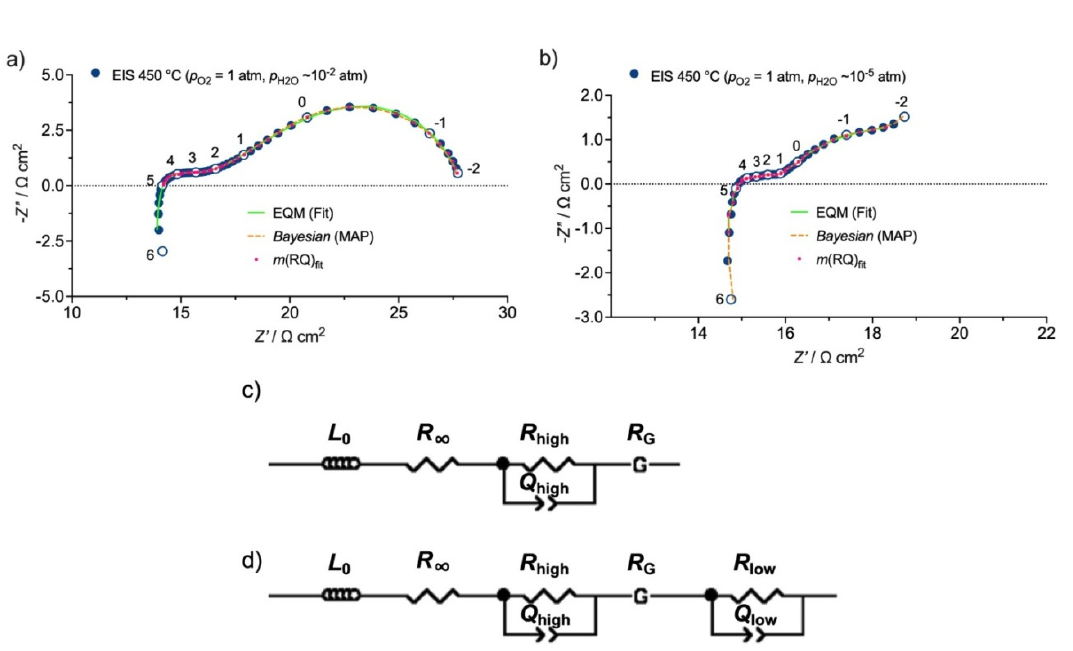
Figure 3. Impedance dispersions obtained under ( a ) wet ( p H2O ~ 10 − 2 atm) and ( b ) low humidity ( p H2O ~ 10 − 5 atm) conditions at 450 °C in O 2 atmosphere (numbers indicate the decades of the measuring frequencies). Equivalent circuit models (EQMs) used to fit the dispersions in ( c ) wet and ( d ) low humidity conditions.